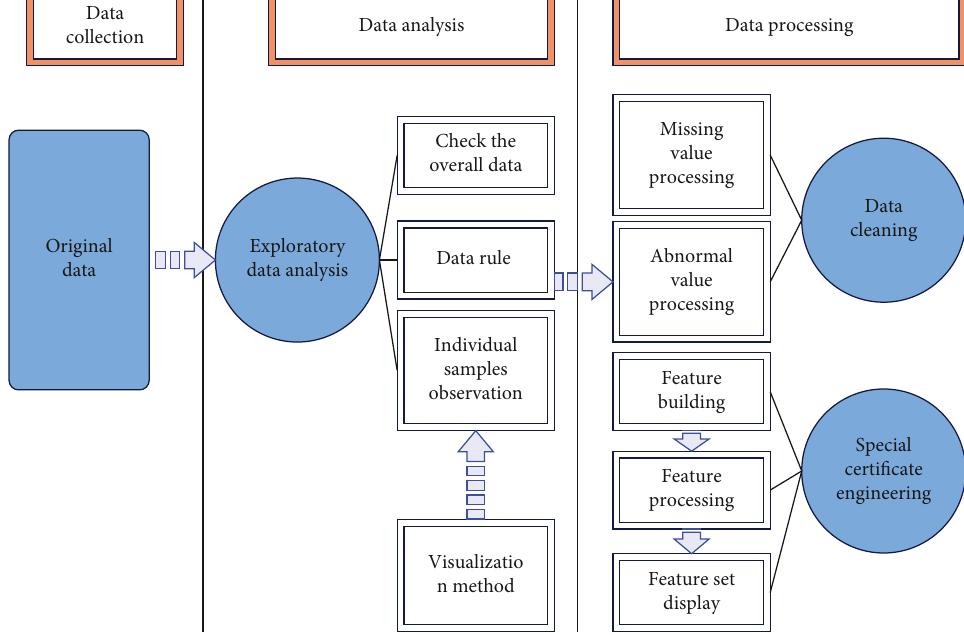
Figure 8: Work flow chart of